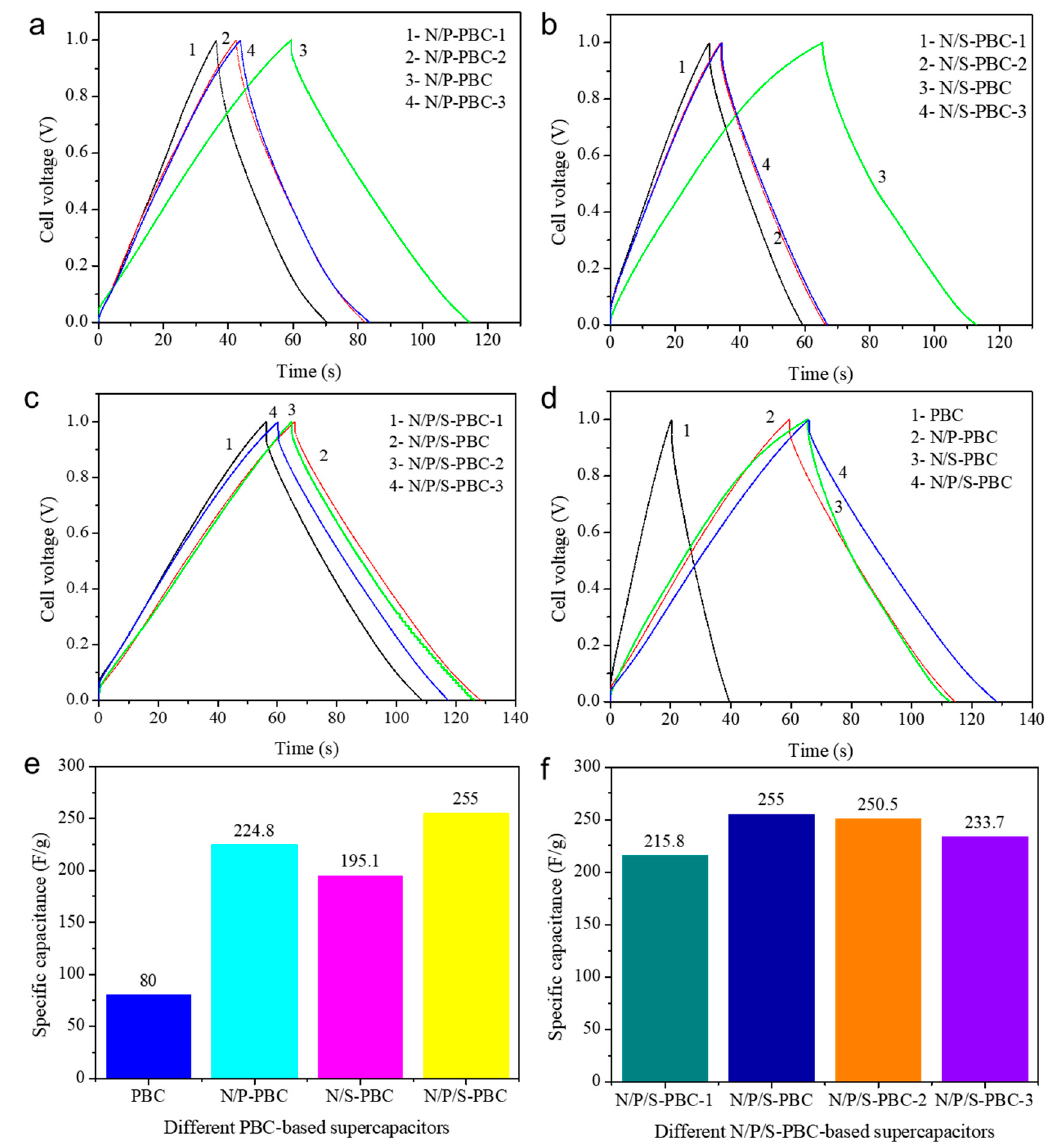
Figure 8. Galvanostatic charge–discharge curves of the different ( a ) N/P-PBC-based supercapacitor, ( b ) N/S-PBC-based supercapacitor, ( c ) N/P/S-PBC-based supercapacitor, ( d ) the different PBCs supercapacitors measured using a two-electrode system in 2.0 M H 2 SO 4 aqueous electrolyte at the current density of 1.0 A/g and the specific capacitor values of ( e ) different pyrolyzed bacterial cellulose nanofiber-based supercapacitors and ( f ) different N/P/S-PBC-based supercapacitors at the current density of 1.0 A/g.